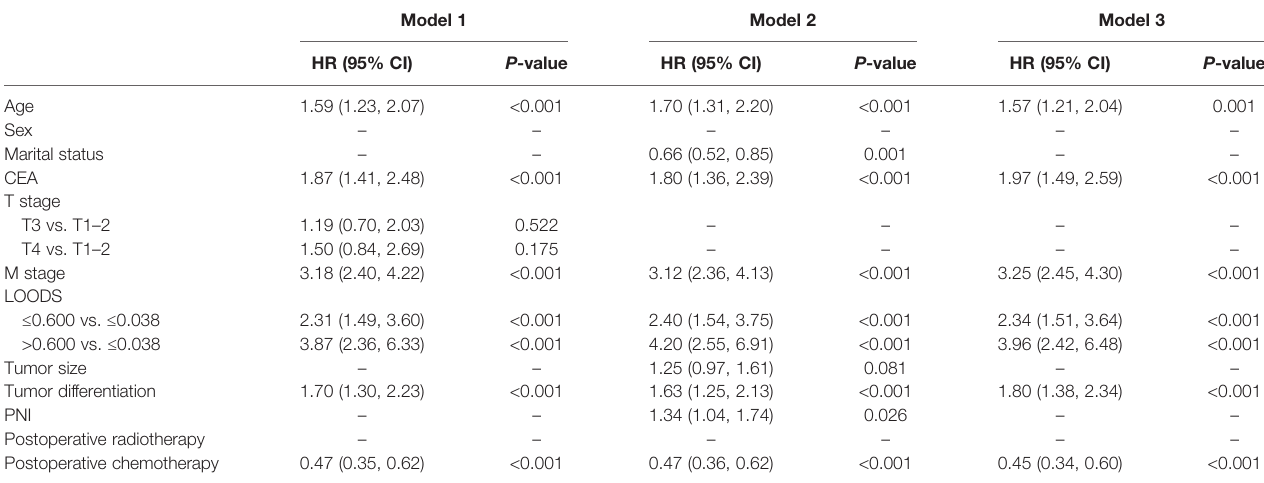
TABLE 3 | Risk factors for rectal cancer patients with tumor deposits in the training set.